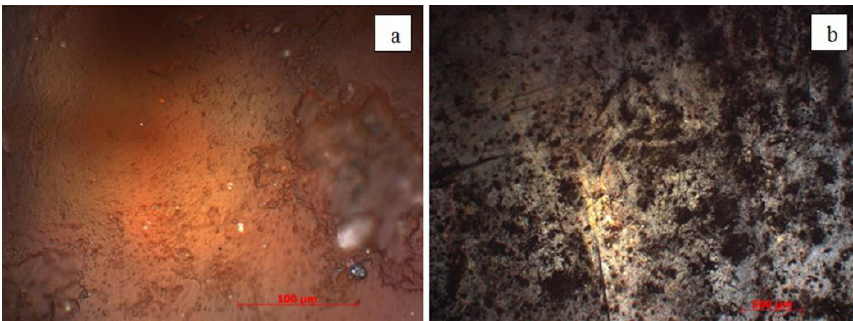
Figure 7. Optical microscopy (OM) microphotographs: ( a ) new varnish; ( b ) old varnish.